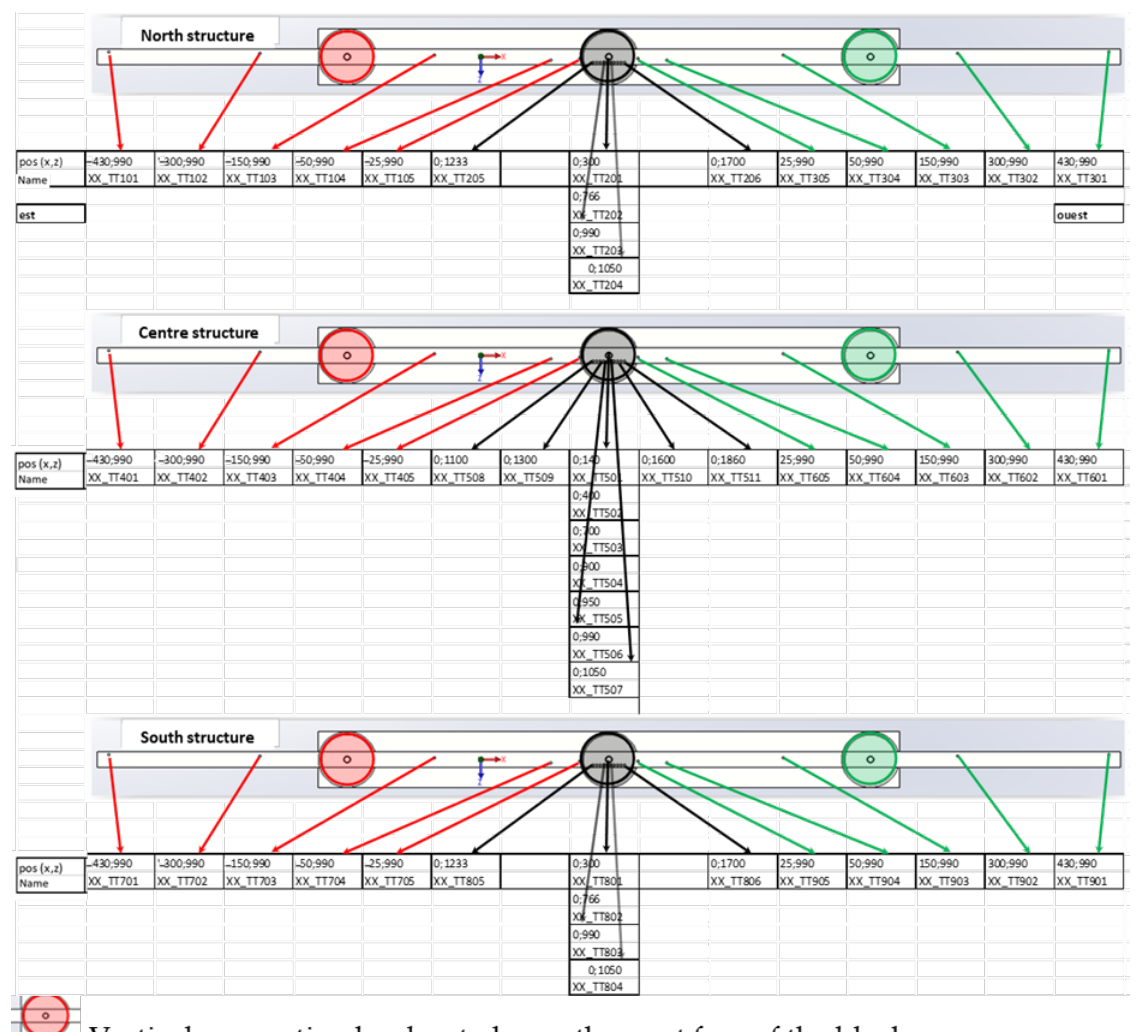
Figure 3. Coordinates (in mm) of the thermocouples in an NRC concrete block considering the origin of the coordinate system at the center of the upper face of the block.